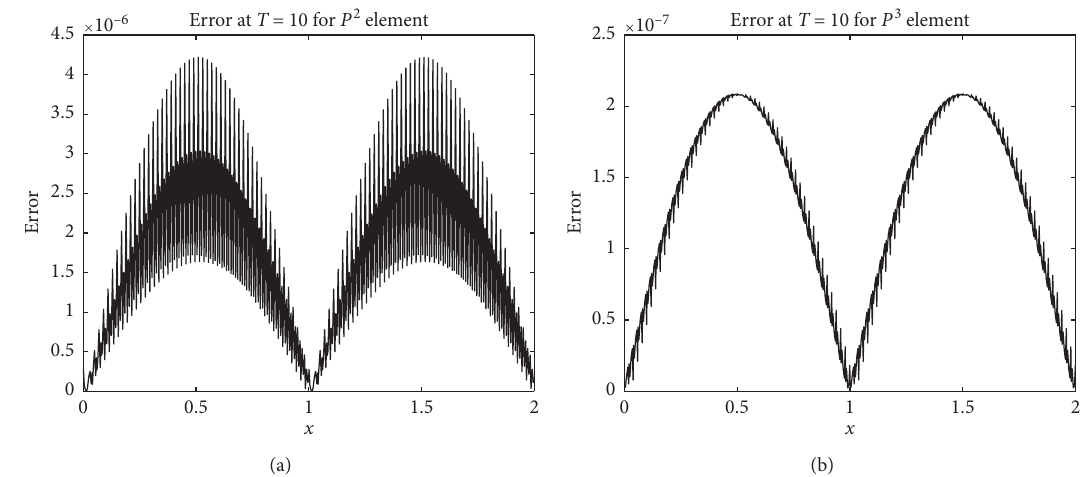
Figure 5: The error ‖ w ( x, t ) − w